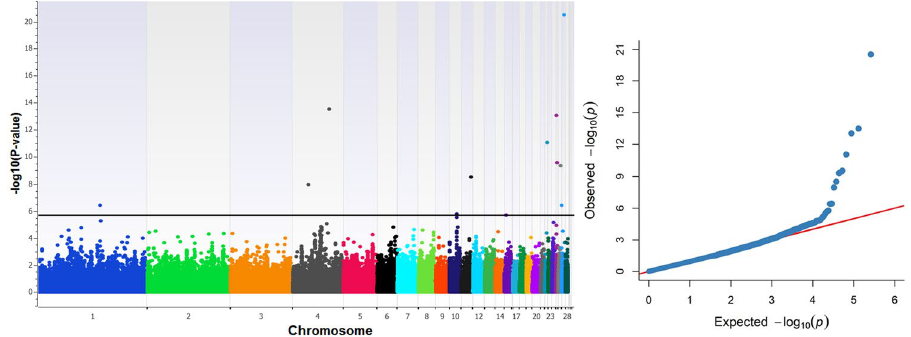
Figure 1. Manhattan plot (left) and quantile-quantile plot (right) for BW. Manhattan plot shows the − log 10 (observed p-values) of the genome-wide SNPs (y-axis) across the 28 autosomes (x-axis), and the horizontal line denotes the genome-wide significant threshold. With regard to the Q-Q plot, the y-axis represents the observed − log − log 10 (p-values) and the x-axis shows the expected 10 (p-values). Manhattan plot was constructed with SNP & Variation Suite (version 8.8.1) software (Golden Helix: http://www.goldenhelix.com) while Q-Q plot with the CMplot package (https://github.com/YinLiLin/R-CMplot) in R (http://www.r-project.org/).